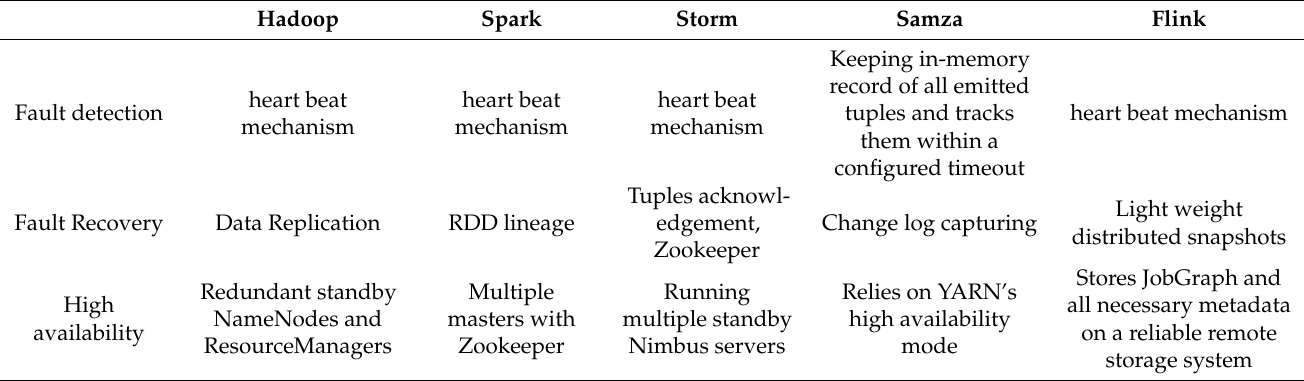
Table 7. Comparison of big data frameworks with respect to features related to fault